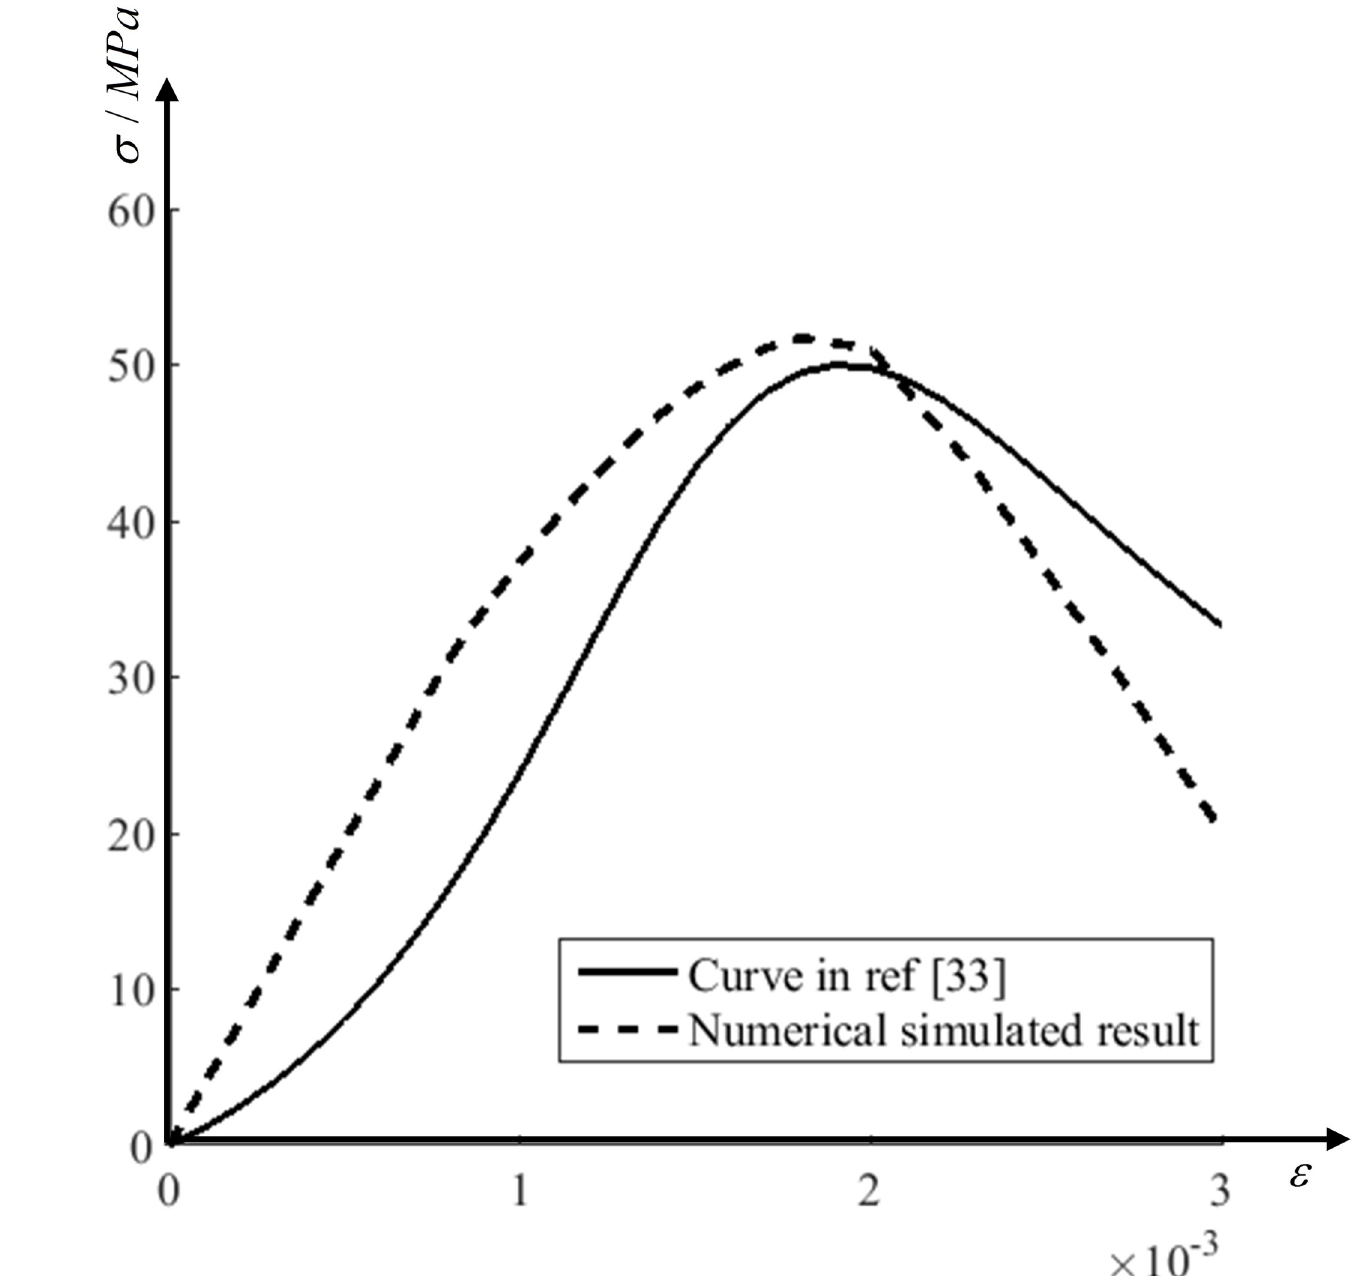
Fig 11. Stress-strain curves of concrete under uniaxial compression. The numerical result obtained from the FE model in Fig 9.